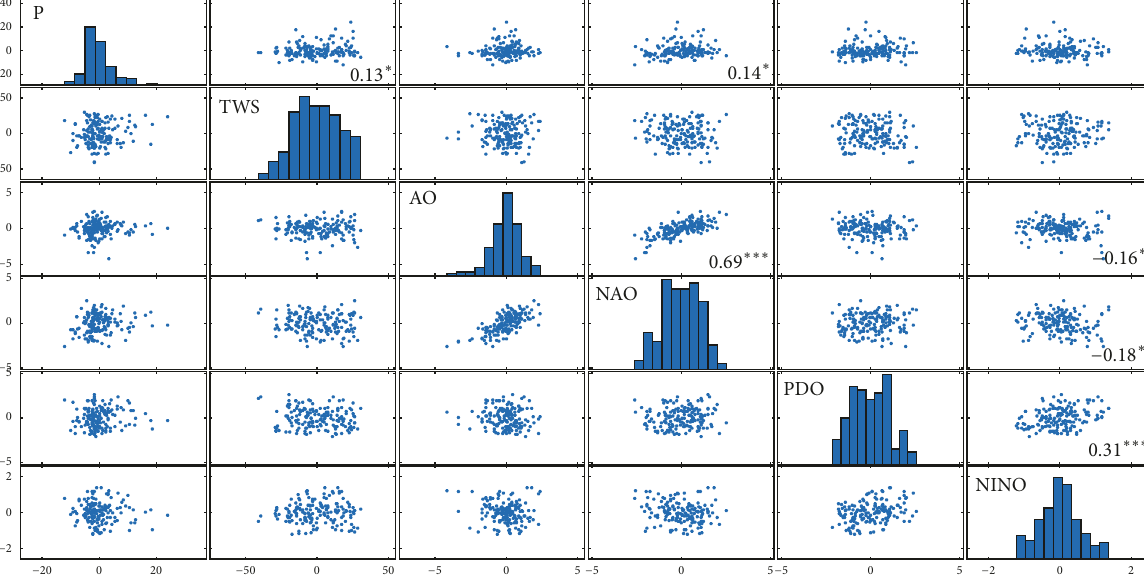
Figure 7: The correlation between precipitation, TWS, and climate indices in the TRB during the period of April 2002–December 2015. “ ∗ ” and “ ∗ ∗ ∗ ” represent the 0.1, 0.05, and 0.001 significant levels, respectively. The histograms at main diagonal represent the probability distributions for these physical factors. The scatter plots represent the correlation between the physical factors at corresponding rows and